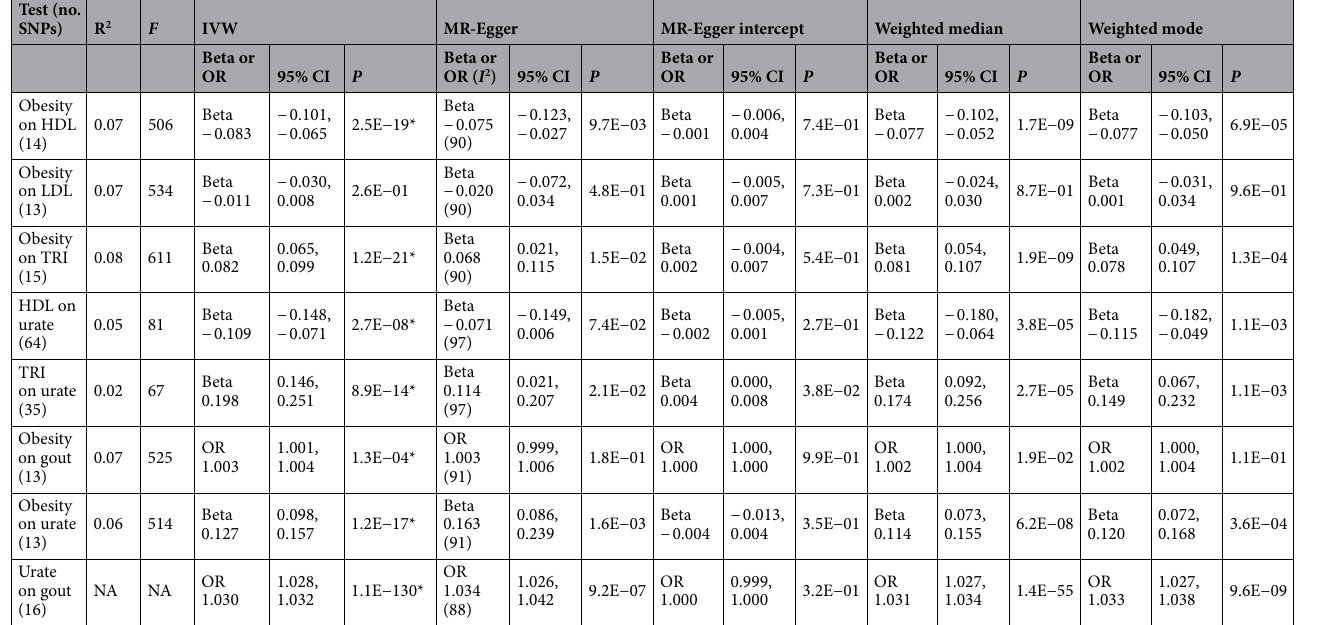
Table 2.. Univariable MR results and sensitivity analyses. R 2 = is the proportion of variability in the exposure explained by the SNPs; F = F -statistic ( F > 10 indicates adequate power); OR = odds ratio; CI = confidence interval. HDL = high-density lipoprotein cholesterol; LDL = low-density lipoprotein cholesterol; TRI = triglycerides. The MR-Egger intercept is highlighted in grey because its interpretation is different than the IVW and sensitivity estimators: P -value < 0.05 for the MR-Egger intercept suggests pleiotropy in the IVW with the direction and magnitude of the IVW estimate.